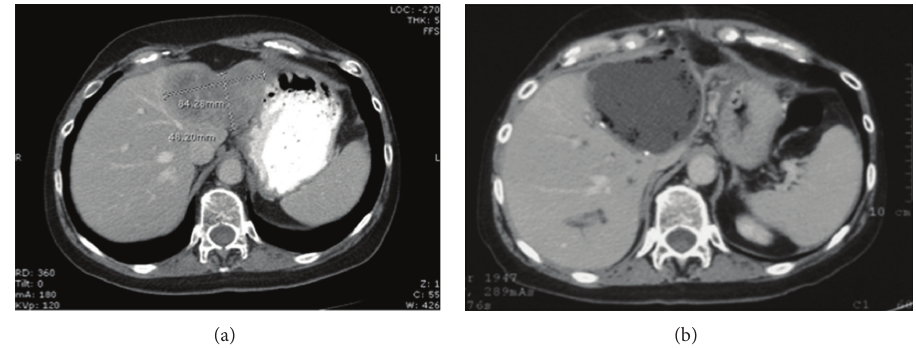
Figure 1: Preoperative and postoperative CT scan of patient. (a) preoperative CT scan of this patient demonstrating a large metastatic breast cancer tumor ( 8.4 × 4.6 cm) located in the left hemiliver abutting the middle hepatic vein. An extended left hepatectomy including caudate lobectomy was performed with negative margins. (b) CT scan performed two weeks after hepatectomy demonstrating a large biloma located in the post-hepatectomy bed.